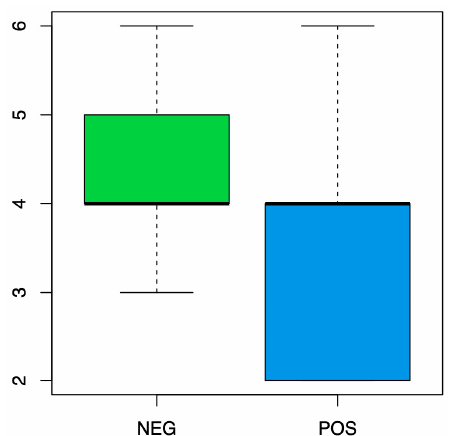
Most of the time, the highest levels of F5 (Figure 5) seem to correspond to a negative IDH, and this variable is statistically significant with a p value = 0.00034 < 0.05 and a cut-off level of F5 = 3. Additionally, F5 = 2 and F5 = 3 have a high probability of 50% and 57%, respectively, of having a positive IDH, while the probability of the other levels is much lower (around 15%). This model has an accuracy of 0.808, a sensitivity of 0.48, a specificity of 0.890, and an AUC of 0.73.